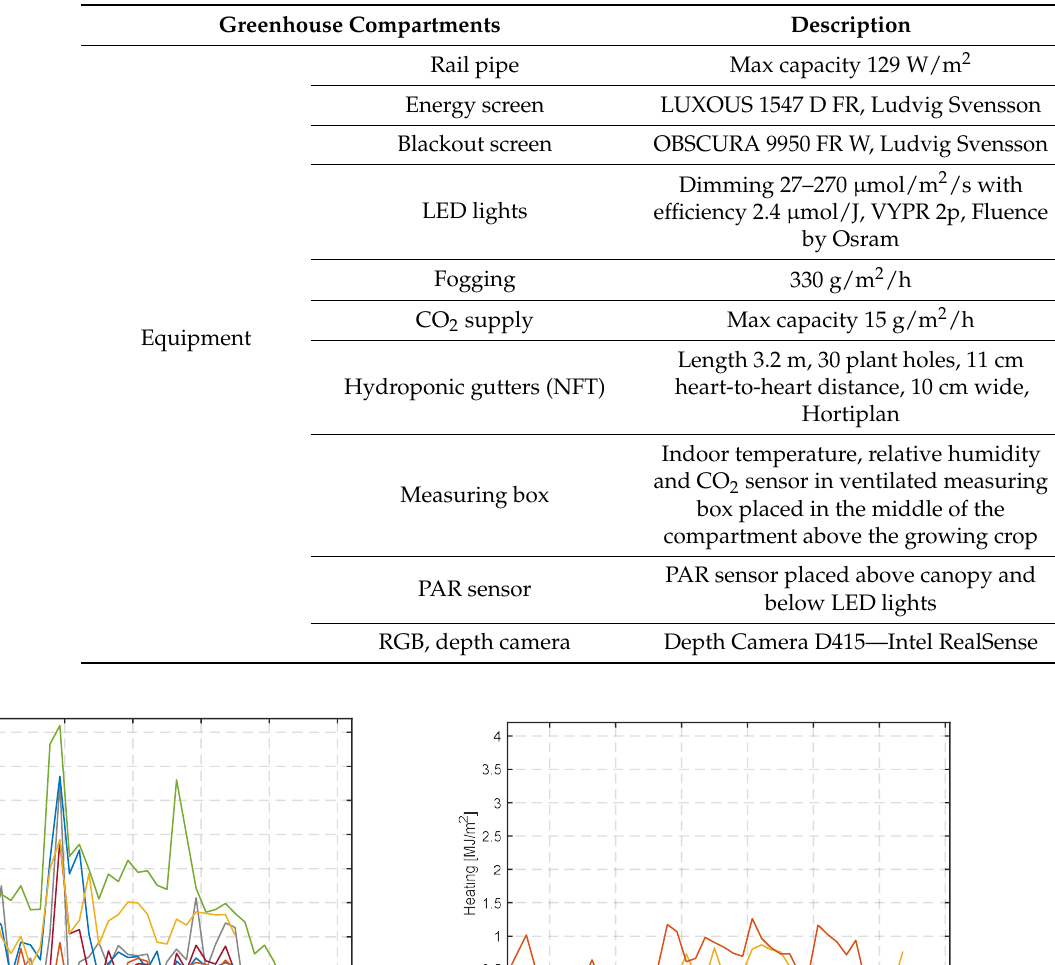
Table A2. Actuators and defaul sensors installed in all the greenhouse compartments during the growing cycles and description of the installed equipment.